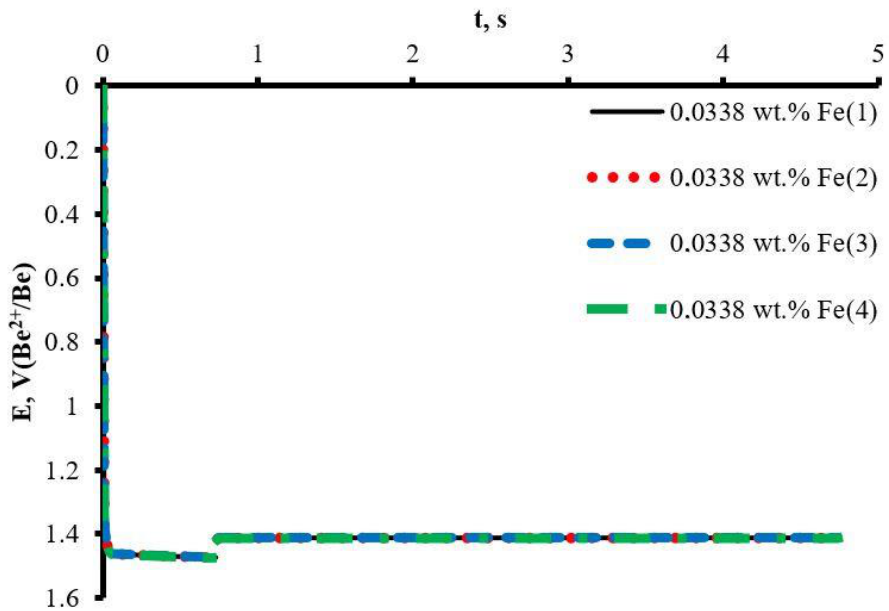
Figure 2. Time–potential dependence in the 0.66LiF–0.34BeF 2 melt. Concentration of Fe was Figure 2. Time – potential dependence in the 0.66LiF – 0.34BeF 2 melt. Concentration of Fe was 0.0338 0.0338 wt.%, T = 923 K; the time between the measurements was 15 wt.%, T = 923 K; the time between the measurements was 15 min.